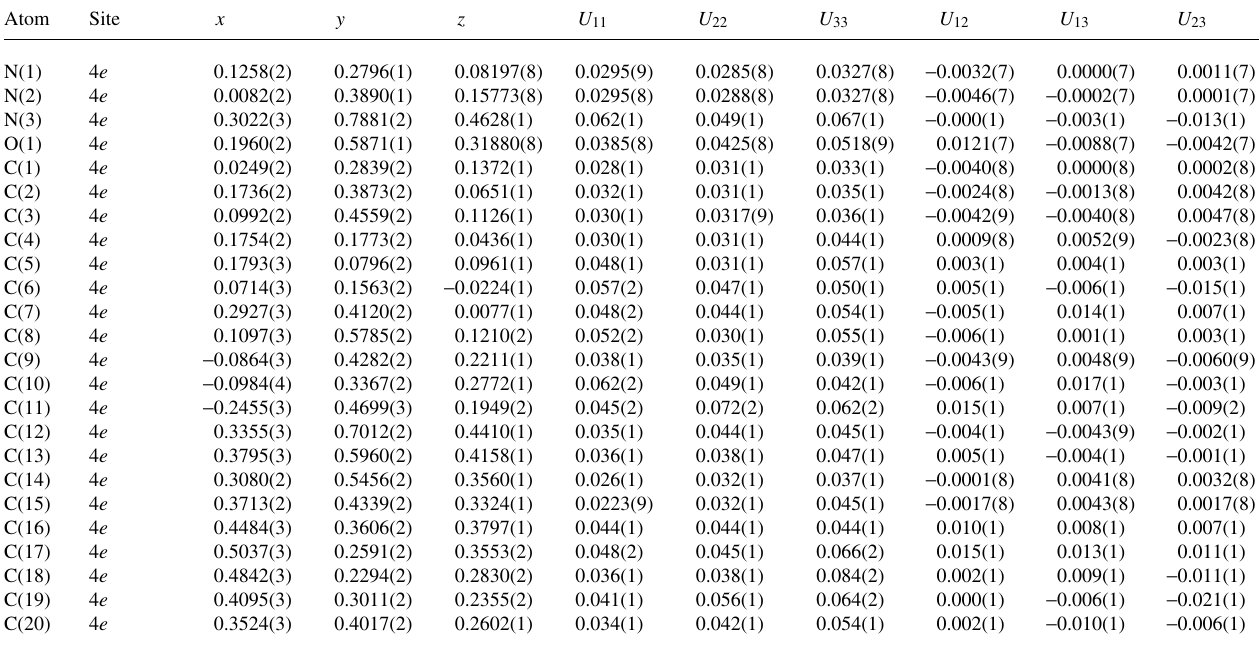
Table 3. Atomic coordinates and displacement parameters (in Å 2 )